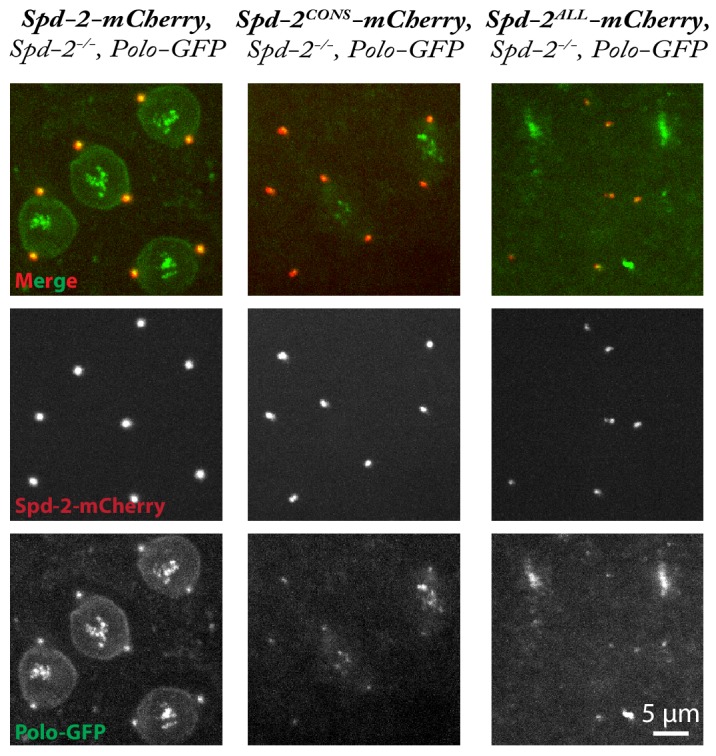
Abnormal Polo-GFP and Spd-2-mCherry distribution and mitotic defects in Spd-2 mutant embryos rescued with Spd-2-CONS-mCherry or Spd-2-ALL-mCherry.Micrographs show stills of living Spd-2 mutant embryos expressing Polo-GFP (green) and either WT Spd-2-mCherry, Spd-2-CONS-mCherry or Spd-2-ALL-mCherry (red, as indicated). Images are maximum intensity projections of z-stacks acquired on a spinning disk confocal microscope. Most embryos rescued with Spd-2-ALL-mCherry did not develop to syncytial blastoderm stages and the few that did exhibited severe defects (as in the example shown here), making it difficult to accurately stage the embryos. The primary cause of these defects is hard to assess, as these embryos tend to keep cycling through repeated cycles of division even after abnormalities occur—so they quickly accumulate defects. Nevertheless, our data are consistent with the possibility that centrosome dysfunction is the major cause of these defects.